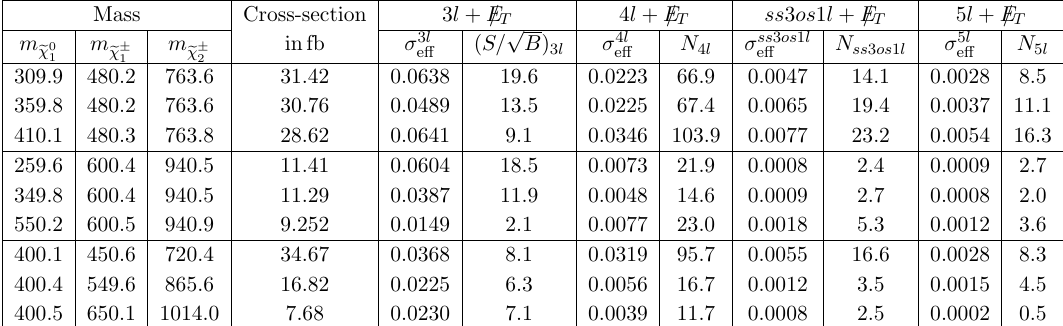
Table 7 . The masses and production cross-sections of all possible eweakino pairs for di(cid:11)erent BPs in the LHLS model are given. For the trilepton signal in each case we display the signi(cid:12)cance p ( S= B ). The corresponding (cid:27) e(cid:11) and total number of signal events (with negligible backgrounds) for each type of multilepton signal with n > 3 are also shown. Masses and cross-sections are in GeV and fb